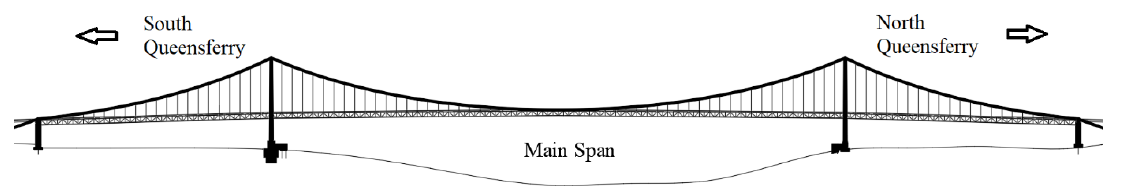
Figure 1. Longitudinal elevation of the Forth Road Bridge (FRB).